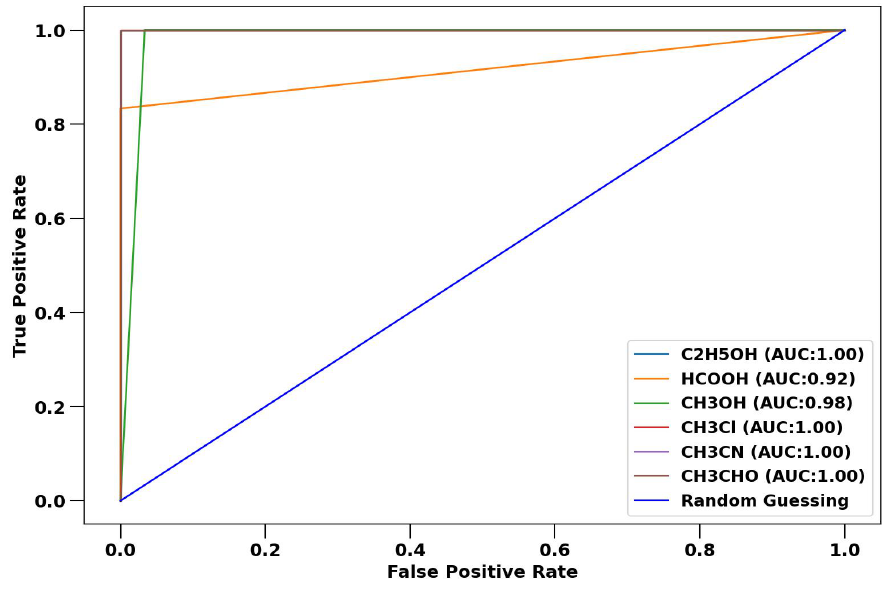
Figure 15. ROC curve for the classification of 36 experimental